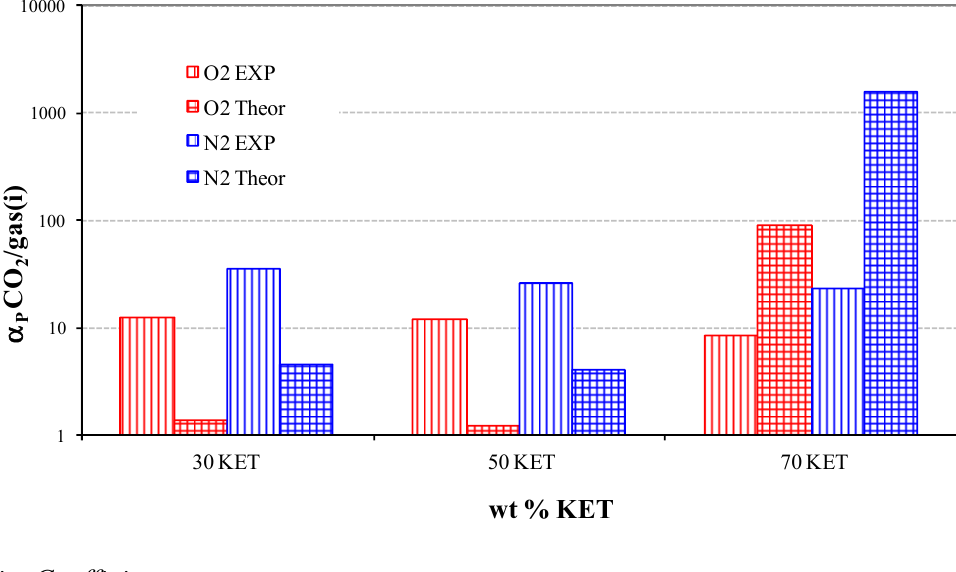
/O ) in modified PEBAX/KET 2 2